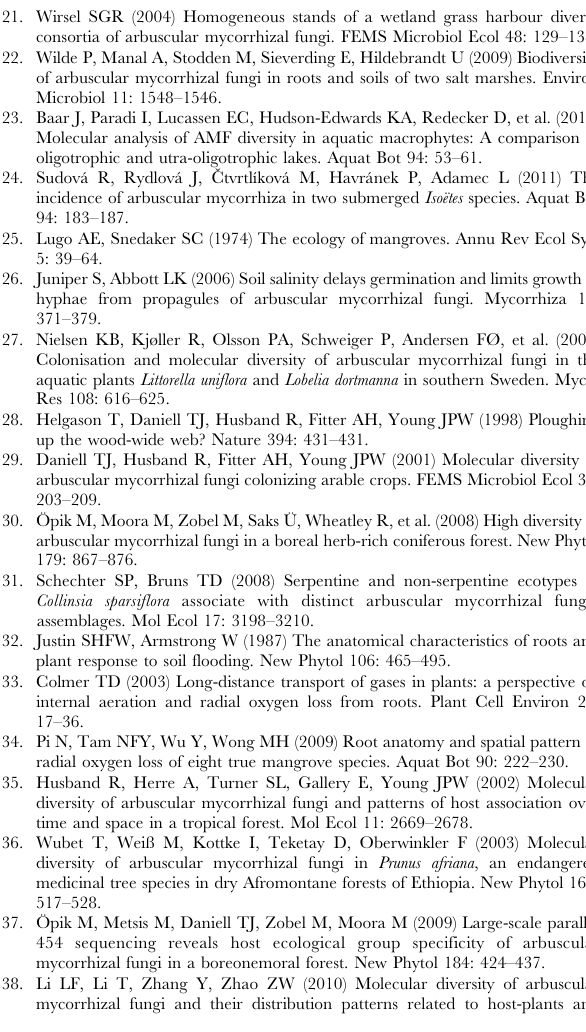
sequences (partial SSU, ITS region and partial LSU rDNA sequences of approx. 1.5 kb, amplified by primers SSUmCf - likelihood (in bold) and NJ analyses, respectively; only support greater than 70% in both analyses is shown. Figure S2 Dendrogram of hierarchical clustering analysis based on the Bray-Curtis ecological distances among AMF communities within the roots (A) from the same host species and (B) from the same tide level. HTL, MTL and LTL represent high, middle and low tide level, respectively; Ai, Hl and Aa represent Acanthus ilicifolius , Heritiera littoralis and Acrostichum aureum , respectively. Table S1 Abundance matrix of AMF sequences (clones) observed in each AMF phylotype within the roots of Acanthus ilicifolius , H. littoralis and Acrostichum aureum at the high, middle and low tide levels.